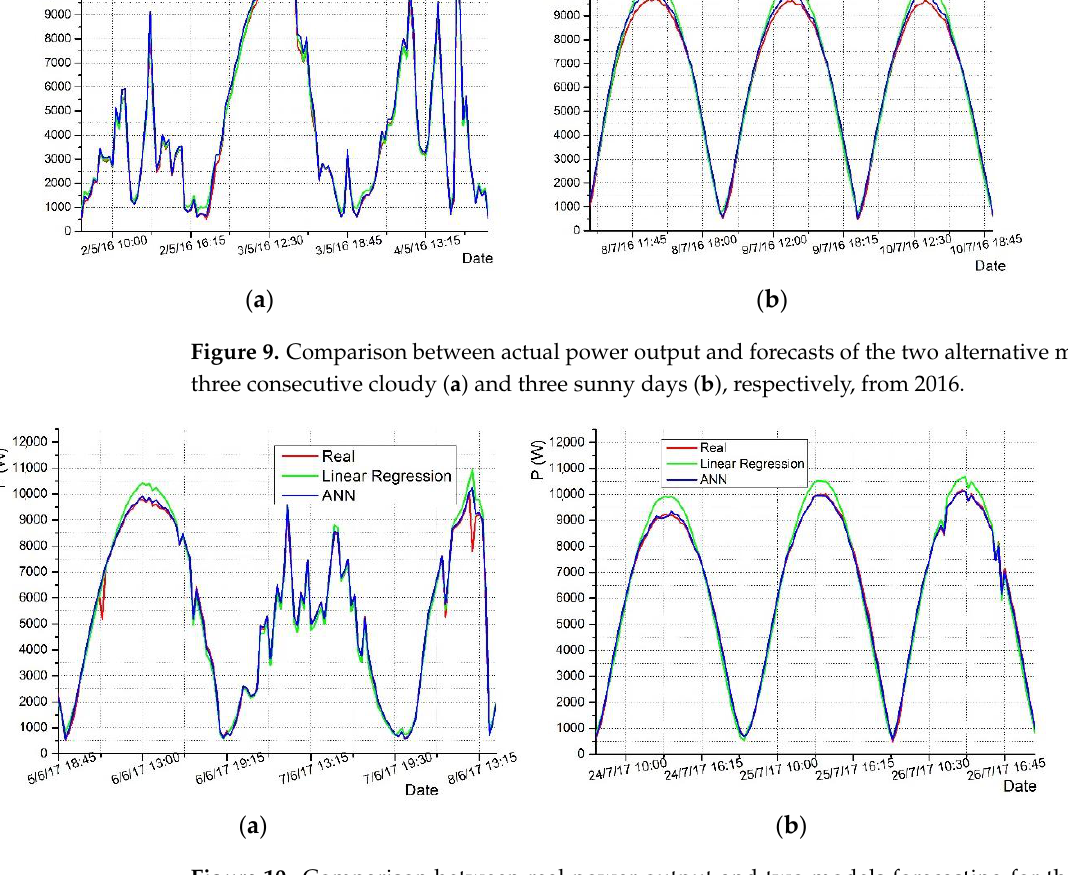
Figure 10. Comparison between real power output and two models forecasting for three cloudy ( a ) and three sunny days ( b ) for 2017.